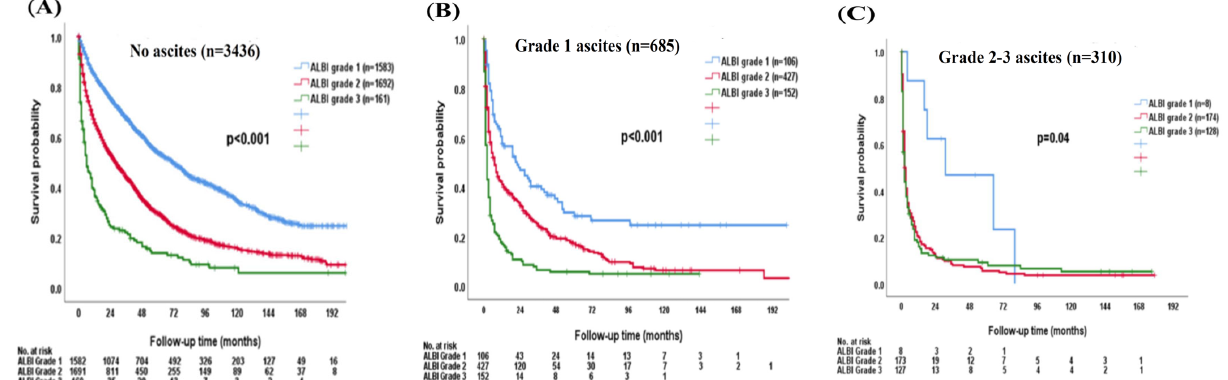
Figure 4. The survival distribution of different ALBI grades according to patients ( A ) without ascites, ( B ) grade 1 ascites, ( C ) grade 2–3 ascites. The ALBI grade can discriminate overall survival in patients without ascites ( p < 0.001), grade 1 ascites ( p < 0.001), and grade 2–3 ascites ( p = 0.04).